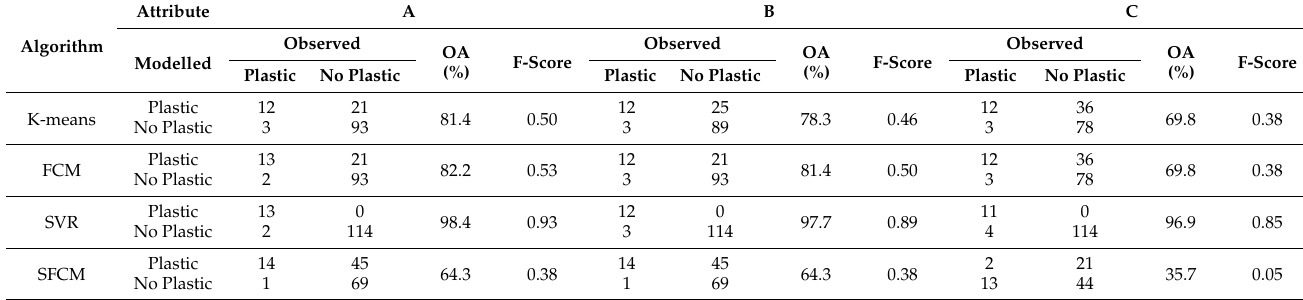
Figure 3. The ( a ) Davies–Bouldin cluster validity index and ( b ) Xie–Beni cluster validity index obtained by using attribute sets ( A – C ) defined in Table 3 to identify optimal cluster numbers using the K-means and fuzzy c-means algorithms, respectively. The horizontal axis shows the number of formed clusters, while the vertical axis provides the value of the cluster validity measures. Table 5. Performance/confusion matrix based on the validation set data using (a) K-means, (b) fuzzy c-means (FCM) and (c) support vector regression (SVR)-based algorithms by considering three different attribute sets A, B, and C, where OA denotes overall accuracy. The numbers in the confusion matrix indicate the number of grids in the validation set belonging to each